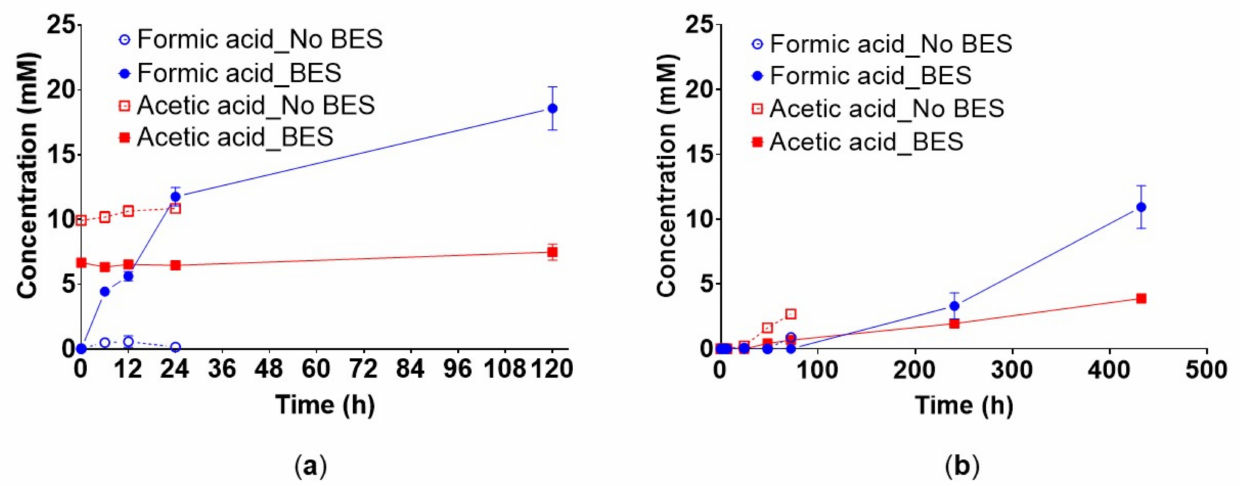
Figure 3. The effect of methanogenesis inhibition by BES (50 mM) on the production and consumption of formate and acetate by the hydrogenotrophic enrichment culture in medium A ( a ) and medium A1 ( b ). Experimental conditions were as specified in Figure 1. The error bars show the standard deviation of the mean of n = 3 and n = 4 for cultures in medium A and A1, respectively. When not visible the error bars are smaller than the symbol. Blue circles: formate, red squares: acetate, filled symbols: BES added, open symbols: